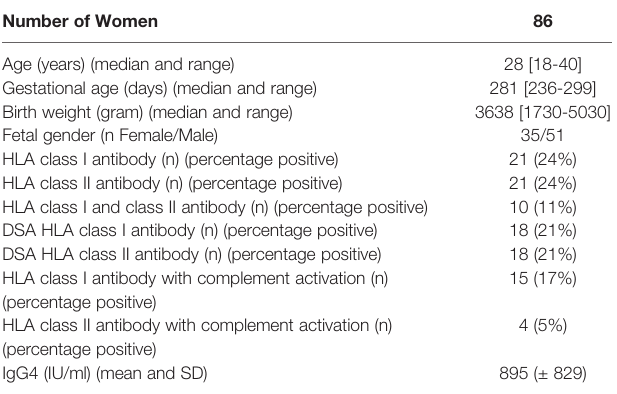
TABLE 1 | Characteristics of participants and sera.